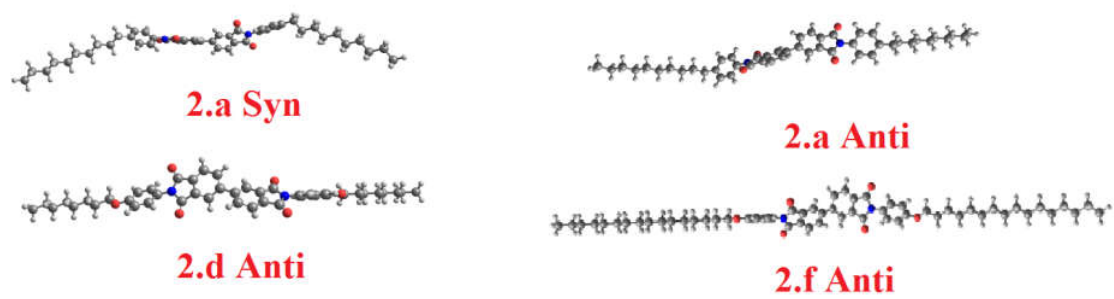
Figure 5. Calculated molecular geometries of Syn conformer of 2a and the anti-conformers of 2a , 2d and 2f .